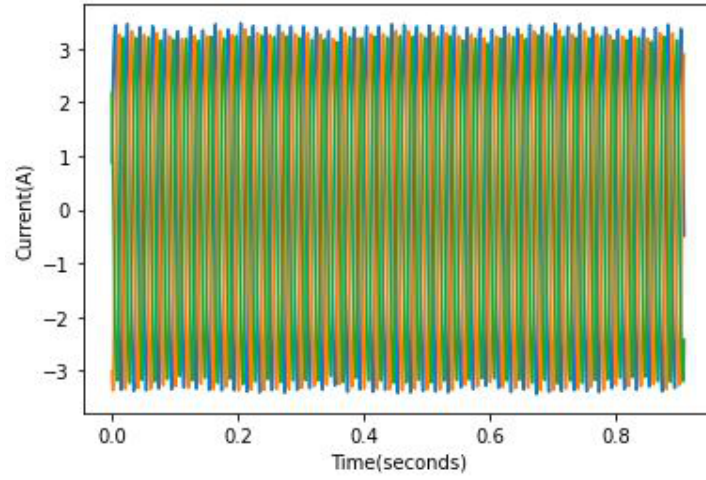
Figure 10. i a current in a healthy case at full load.